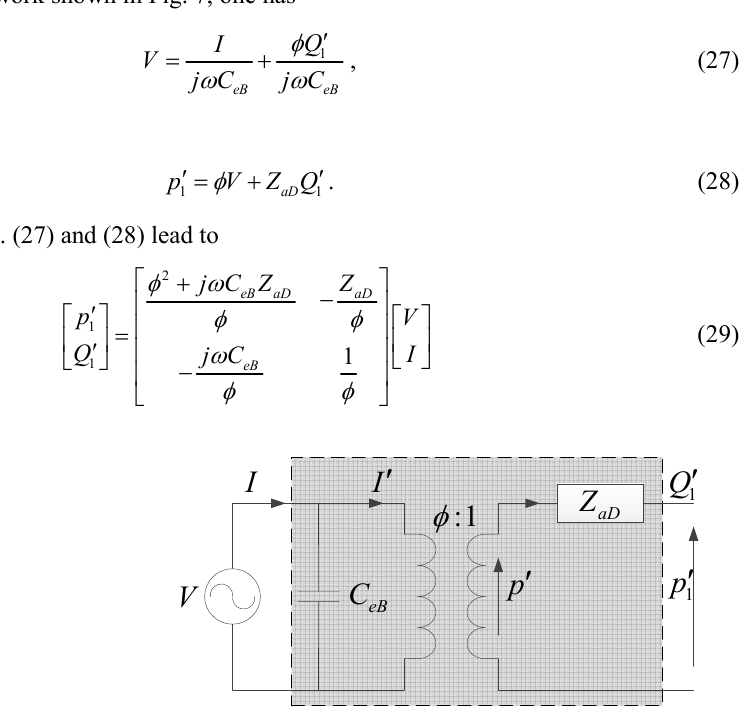
Fig. 7 Equivalent electric network representation for a PZT-disc.